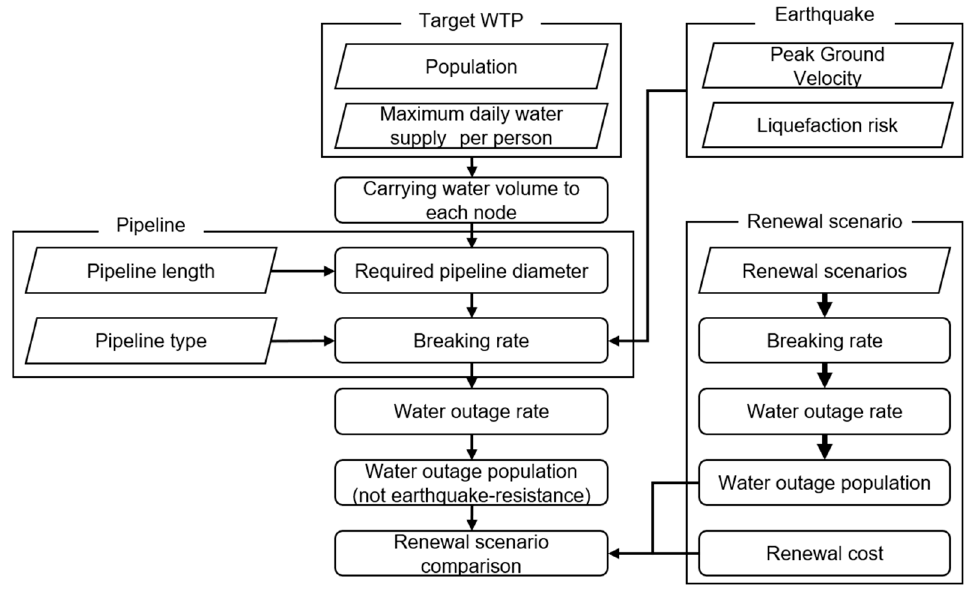
Figure 1. The framework of the water outage population calculation model. The parallelogram and square boxes show the input and output data, respectively.